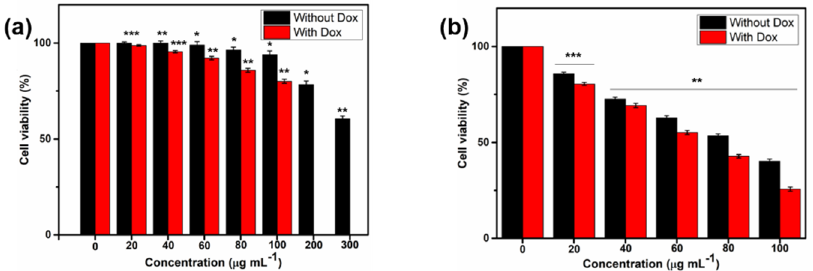
Figure 6. Cytotoxicity of PA-AgNPs with or without Dox ( a ) on 3T3 cells ( b ) on 4T1 cells. (Data characterize the mean ± SD, n = 6, * p < 0.05, ** p < 0.01, and *** p < 0.01, which were compared with the control group, Student’s t -test.)